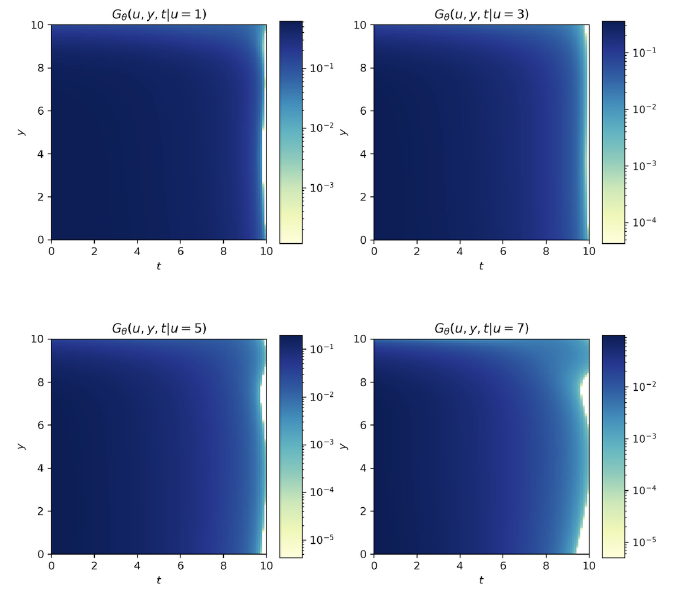
Figure 11. The values of G θ ( u , y , t ) for a fixed u (exponential distribution).